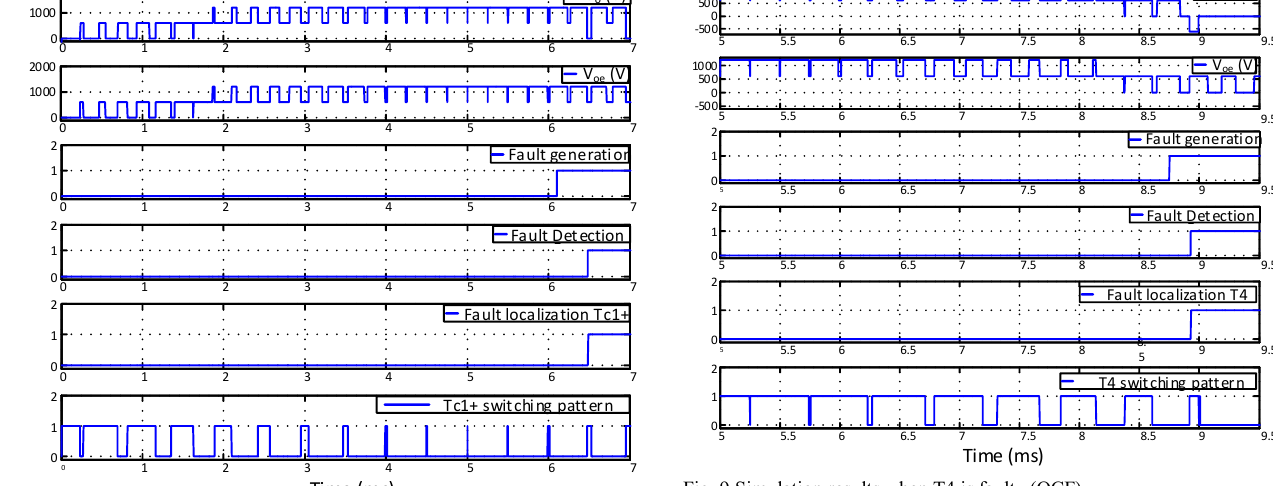
Fig. 9 Simulation results when T4 is faulty (OCF).